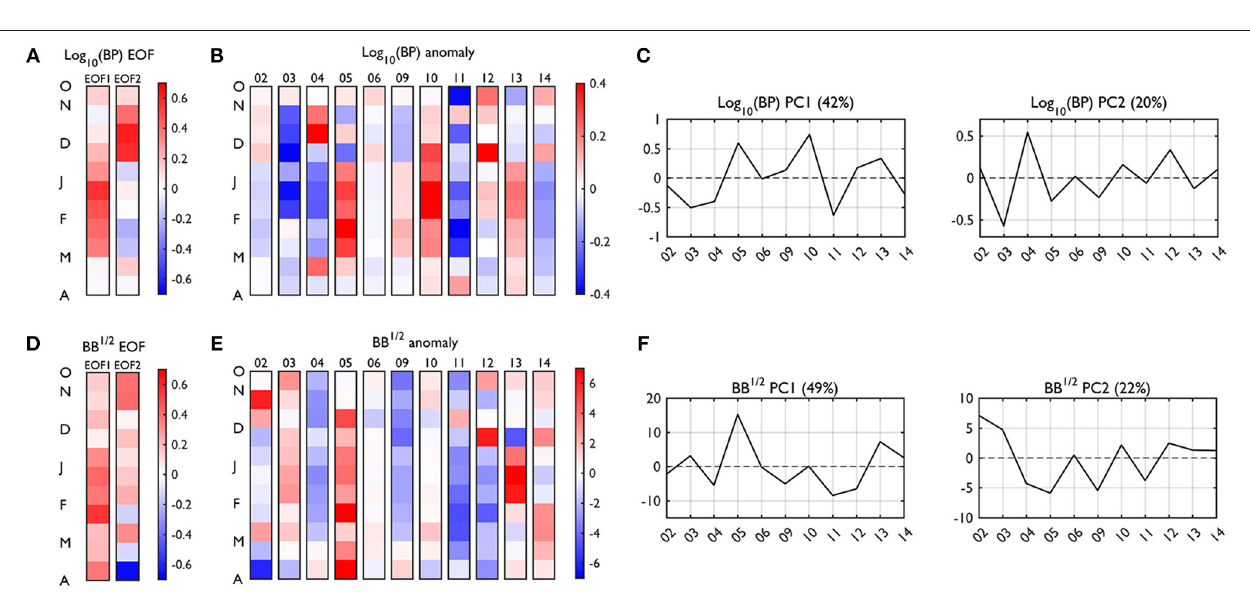
FIGURE 7 | Climatology of BP (A), BB (B), PP (C), and Chl (D). Climatology (2002–2003 to 2014–2015) of depth-integrated (0–50m) BP (A) , BB (B) , PP (C) , and Chl (D) for a full growing season. The data in the calculation are RSOA-interpolated data. Error bars indicate 1 standard error.